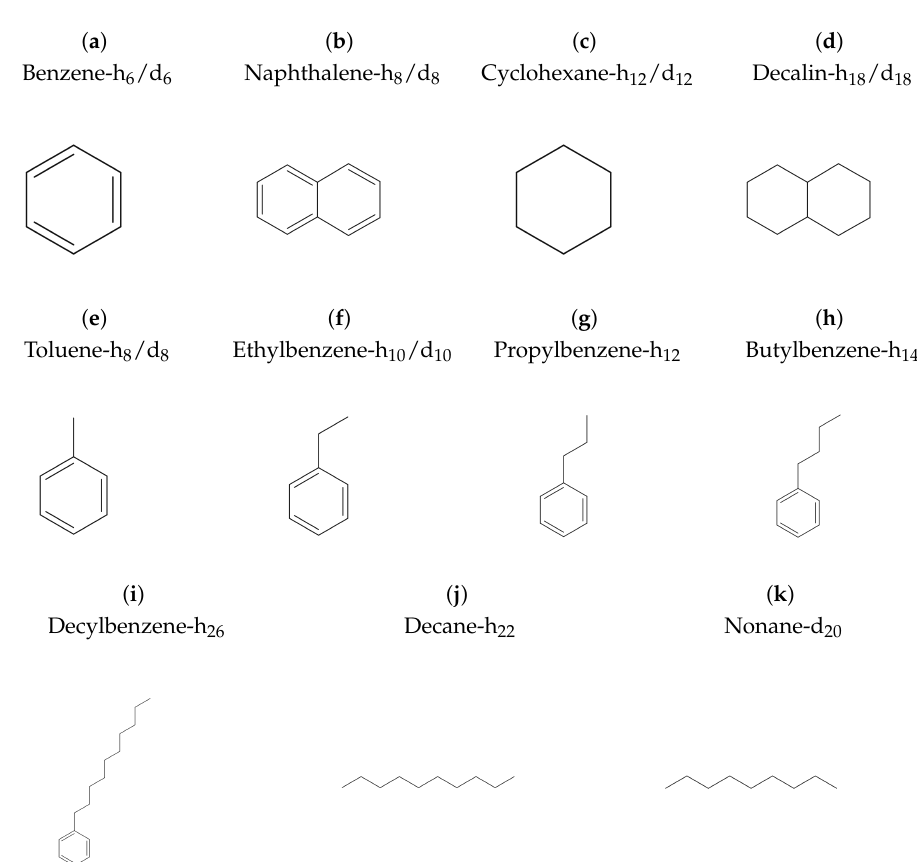
Figure A1. The chemicals used in this study include cycloalkanes ( a – d ), alkylbenzenes ( e – i ), as well as linear alkanes ( j , k ). The cycloalkanes can be distinguished in monocyclic ( a , c ) and bicyclic ( b , d ), as well as in aromatic ( a , b ) and aliphatic ( c , d ) ring systems. Protons and deuterons are not shown for clarity. The individual headings specify the used variants ( 1 H, 2 H). MolView was used to generate the structural formulas.